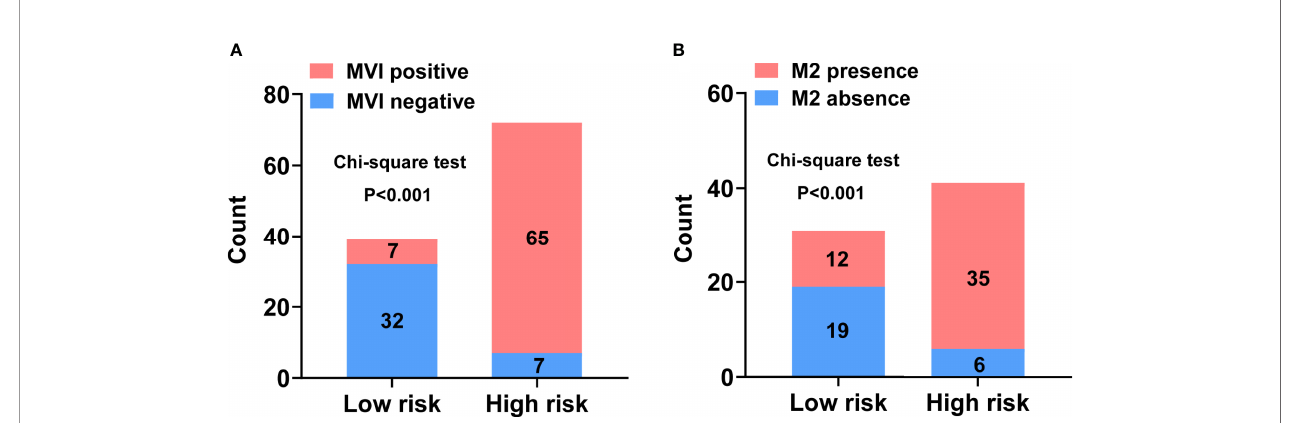
FIGURE 4 | Discriminatory power of the nomograms for MVI and its M2 grade with bar charts. Risk classi fi cation of the predictive nomograms conducted by the maximum Youden index, and the performance in distinguishing the MVI (A) and its M2 grade (B) . P -values were calculated by the chi-square test.